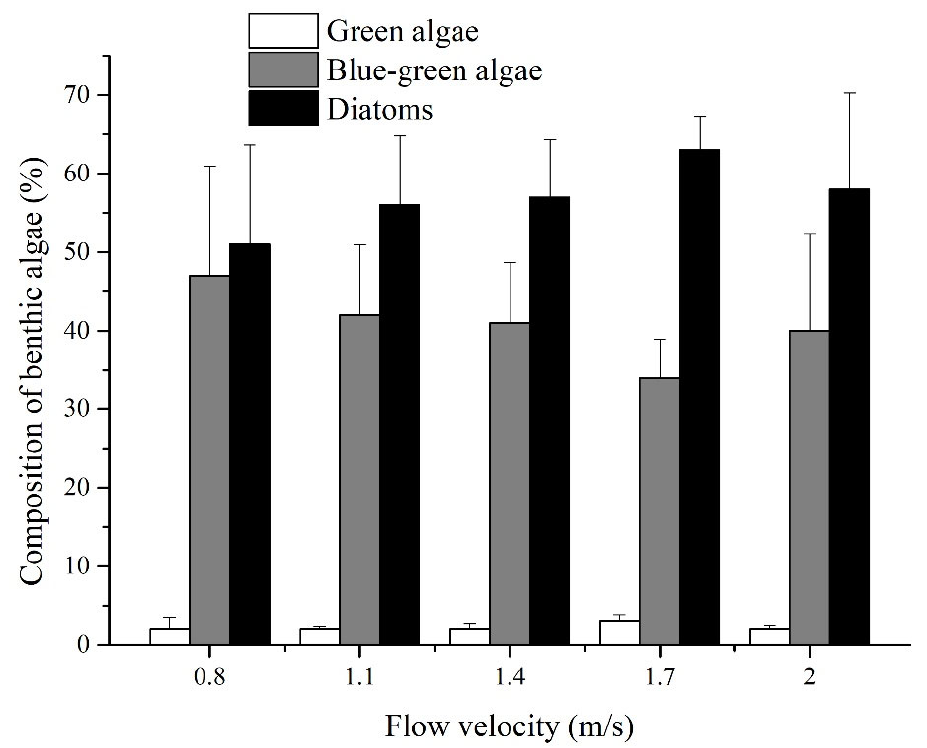
Figure 3. The composition of benthic algae on cobbles before treated (in cell counts, %), which was the average of the 3 replicates at each flow velocity of 0.8, 1.1, 1.4, 1.7, and 2.0 m/s.